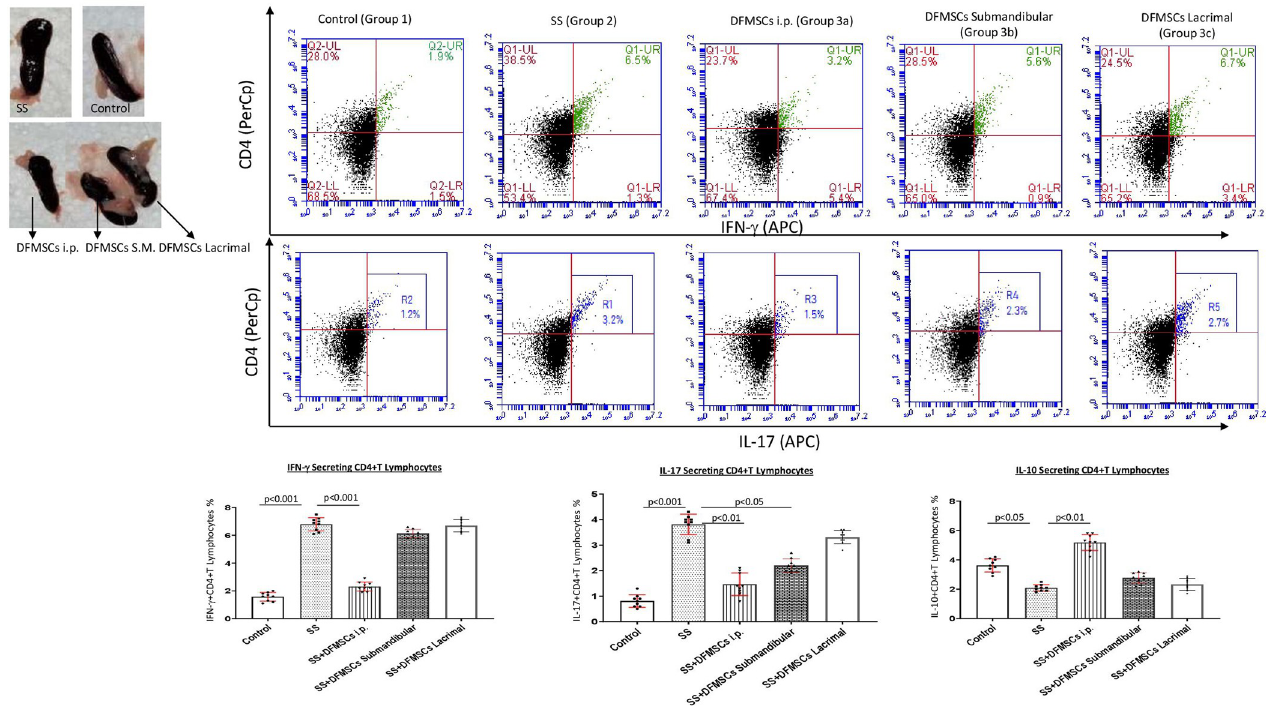
Fig 3. Cytokine secreting CD4+T lymphocyte ratio. The intraperitoneal injection of DFMSCs significantly reduced the CD4+IFN- γ + T cell ratio compared to Group 2 (p < 0.001). The submandibular and lacrimal injections of DFMSCs tended to decrease the CD4+IFN- γ + T cell ratio (6.2 ± 0.4% and 6.7 ± 0.6%) in the splenocytes, but no significant difference was observed when compared with Group 2 (p > 0.05 and p > 0.05). The intraperitoneal and submandibular injections of DFMSCs significantly reduced the CD4+IL-17+ T cell ratio compared to Group 2 (p < 0.001 and p < 0.005, respectively). The lacrimal injected DFMSCs tended to decrease CD4+IL-17+ T cell ratio in the splenocytes, but no significant difference was observed when compared with Group 2 (p > 0.05). The intraperitoneal injection of DFMSCs significantly increased CD4+IL-10+ T cell ratio in Group 3a compared to Group 2 (p < 0.01), but no significant difference was observed in submandibular and lacrimal injected DFMSCs when compared with Group 2 (p > 0.05 and p > 0.05, respectively). and significantly decreased the secreted IFN- γ and IL-17 levels (15.9 ± 4.2 pg/mL and 203.7 ± 19.2 pg/mL, respectively) compared to Group 2 (p < 0.01 and p < 0.01, respectively). Subman- dibular and lacrimal injections of DFMSCs did not significantly change the secreted IFN- γ (36.9 ± 11.6 pg/mL and 34.7 ± 7.8 pg/mL) (p > 0.05 and p > 0.05, respectively), IL-17 (265.2 ± 57.4 pg/mL and 271.9 ± 41.5 pg/mL) (p > 0.05 and p > 0.05, respectively), and IL-10 levels (12.8 ± 3.5 pg/mL and 10.1 ± 3.2 pg/mL) when compared with Group 2 (p > 0.05 and p > 0.05, respectively) Fig 4A . The secreted IFN- γ and IL-17 levels in the saliva were significantly high in Group 2 (IFN- γ : 16.2 ± 6.3 pg/mL, IL-17: 19.8 ± 5.7 pg/mL) compared to Group 1 (IFN- γ : 8.2 ± 2.1 pg/mL, IL-17: 2.9 ± 1.2 pg/mL) (p < 0.01 and p < 0.001, respectively). There was no significant difference between Group1 (11.7 ± 3.9 pg/mL) and Group 2 (10.8 ± 1.7 pg/mL) in IL-10 levels in the saliva (p > 0.05). Intraperitoneal injection of DFMSCs significantly increased IL-10 levels in Group 3a (16.5 ± 3.8 pg/mL) (p < 0.05), and significantly decreased the secreted IFN- γ and IL-17 levels (11.3 ± 2.1 pg/mL and 12.1 ± 2.4 pg/mL, respectively) compared to Group 2 (p < 0.05 and p < 0.05, respectively). Submandibular injection of DFMSCs significantly decreased the secreted IFN- γ and IL-17 levels in the saliva (8.3 ± 1.9 pg/mL and 9.6 ± 0.5 pg/mL, respectively) compared to Group 2 (p < 0.01 and p < 0.05, respectively). Submandibular injection of DFMSCs significantly increased IL-10 levels in the saliva (14.2 ± 3.6 pg/mL) compared to Group 2 (p < 0.05) Fig 4B .